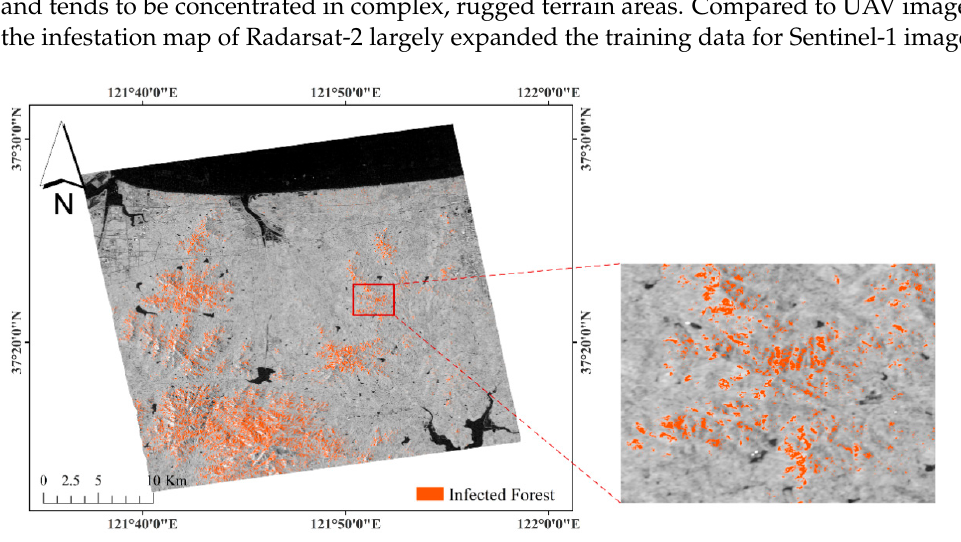
Table 4. Confusion matrices and accuracy indices of random forest algorithms corresponding to Radarsat-2 and Sentinel-1 data.